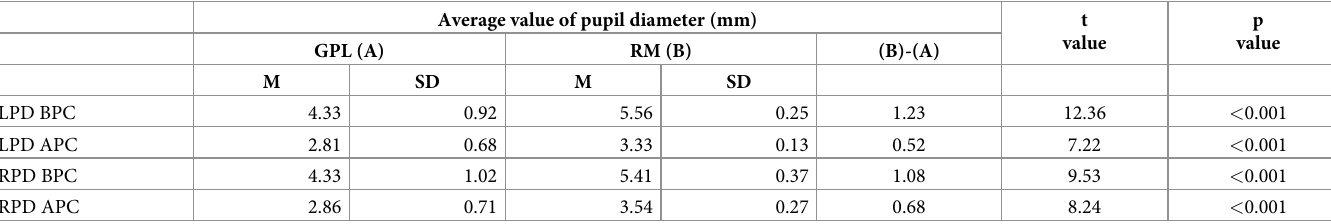
Table 2. Comparison of the GPL and the RM (N =